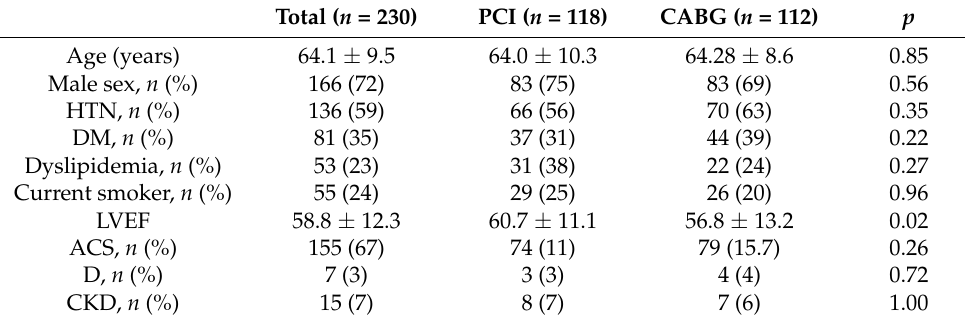
Table 1. Baseline demographic and clinical